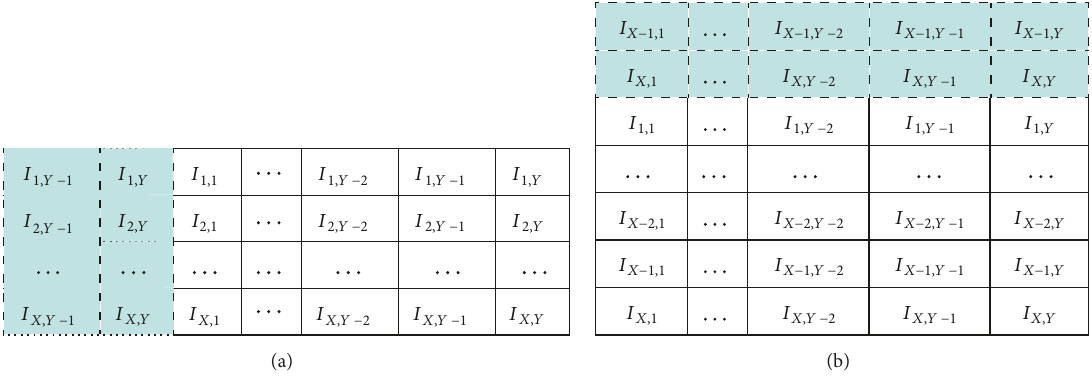
Figure 4: Demonstration of handling edge of an image. (a) Horizontally expanding when the first column is processing. (b) Vertically expanding when the first row is processing. The mask size is